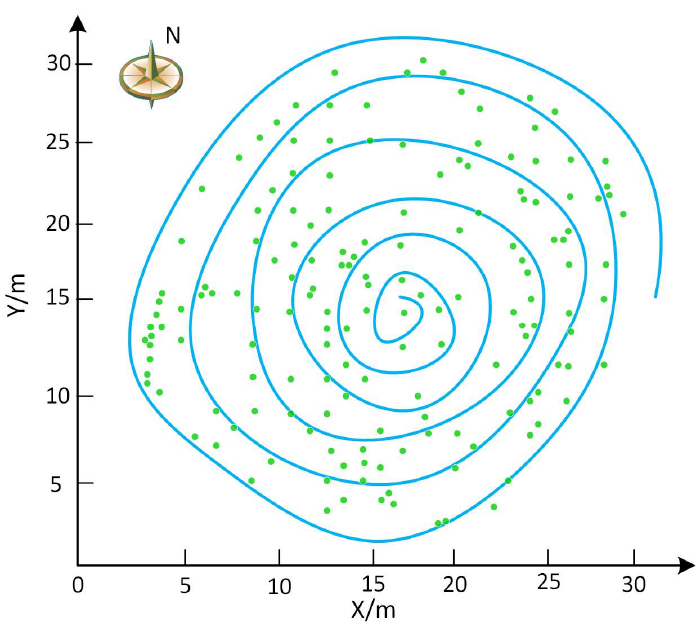
Figure 3. Photogrammetric route and trees distribution in the plot.